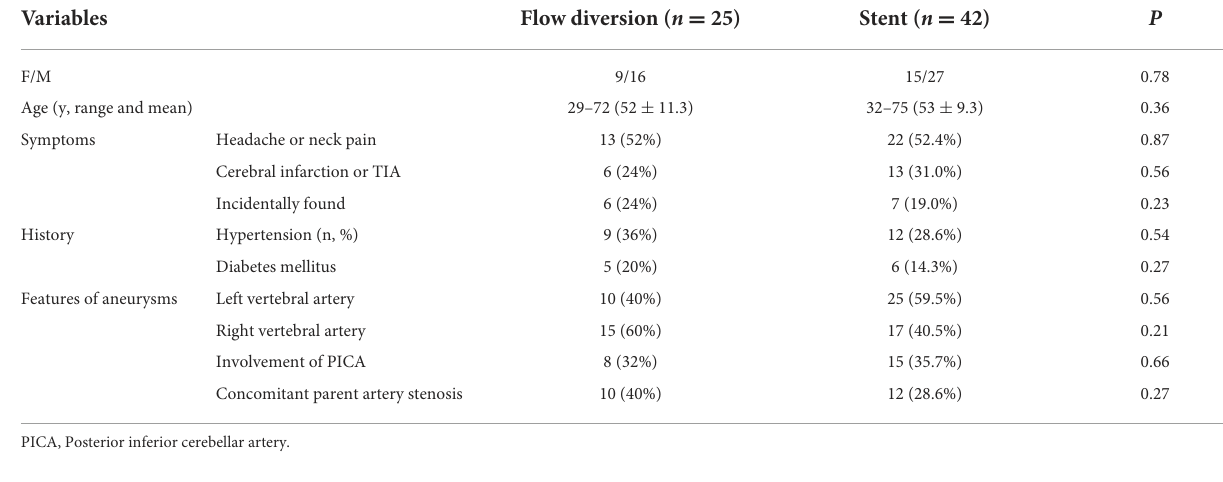
TABLE 1 Demography (n, %).